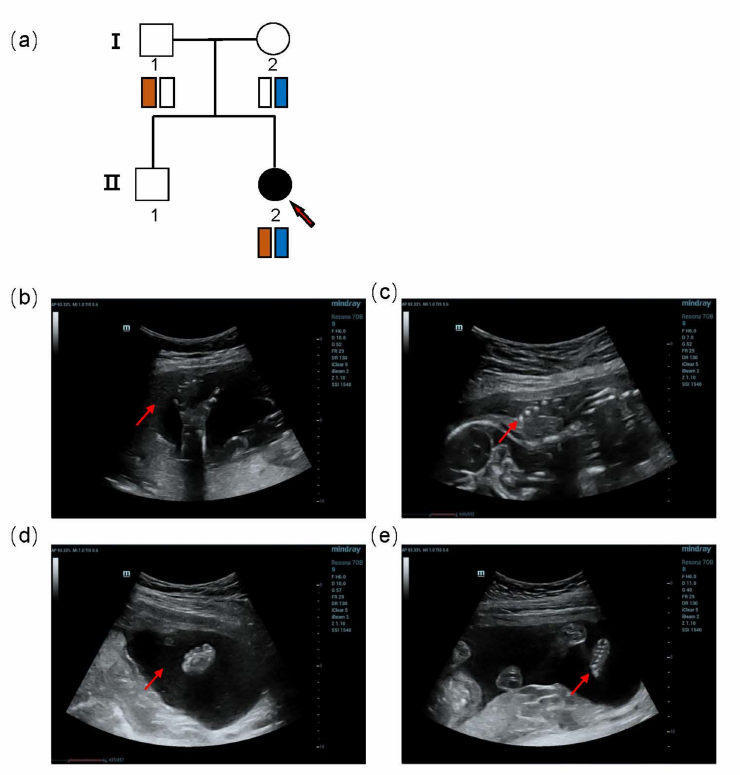
Figure 1. Family pedigree and Ultrasound imaging data of the fetus showed PAPA. ( a ) A Pedigree of this family with segregating PAP in an autosomal recessive manner. Circles and squares represent females and males, respectively. Clear symbols represent unaffected members, while filled symbols show affected members. ( b , c ) Ultrasound imaging for right hand ( b ) and left hand ( c ) displaying PAPA. ( d , e ) Ultrasound imaging for right foot ( d ) and left foot ( e ) exhibiting PAPA. Sequencing data were annotated according to the previously described pipeline